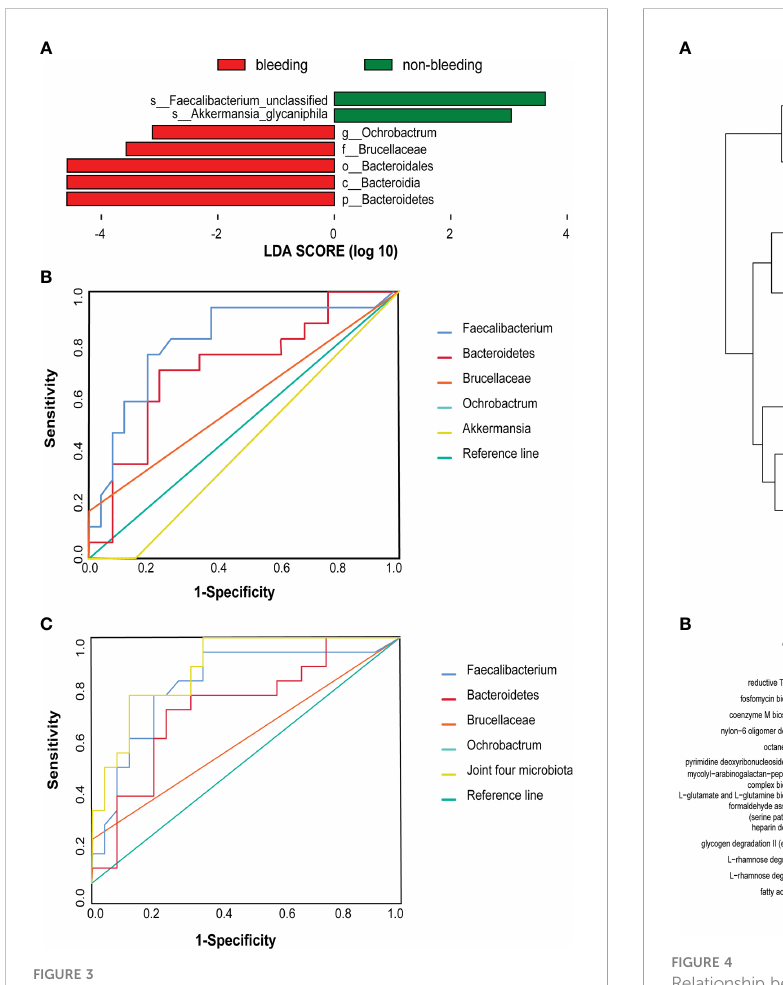
FIGURE 4 Relationship between gut microbiota and clinical indexes, the different pathways of the two disease groups predicted by PICRUSt2. (A) Heat map of Spearman ’ s rank correlation coef fi cient among clinical indexes and gut microbiota. Red cells indicate positive correlations, whereas blue cells indicate negative correlations. (B) STAMP plot shows the differential pathways between the AF and AF-OAC groups. *P < 0.05, **P < 0.01.